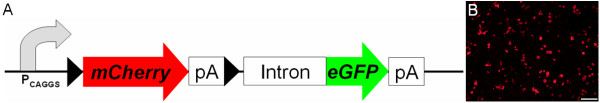
The construct and its verification. A) The construct consists of a loxP flanked mCherry cassette, which is driven by the chicken β-actin promotor with CMV enhancer, followed by an intron-eGFP cassette, which will only be expressed after Cre-mediated recombination. Black triangles illustrate the loxP sites. B) Expression of mCherry was validated in HEK-293 cells after transient transfection. Scale bar is 100 μm.